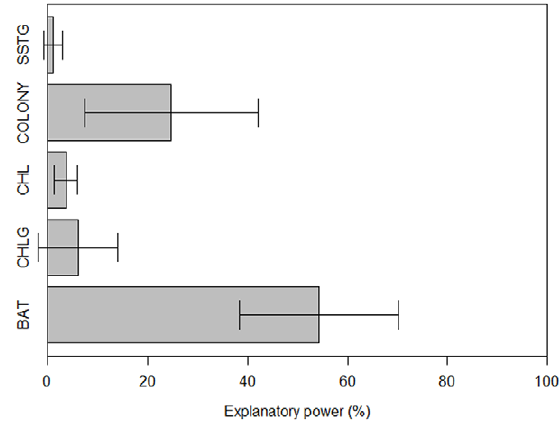
Figure 3. Variable importance estimated by the jackknife test. Bars indicate the explanatory power (in terms of gain) when only a single predictor is included in the model with 95% confidence intervals.